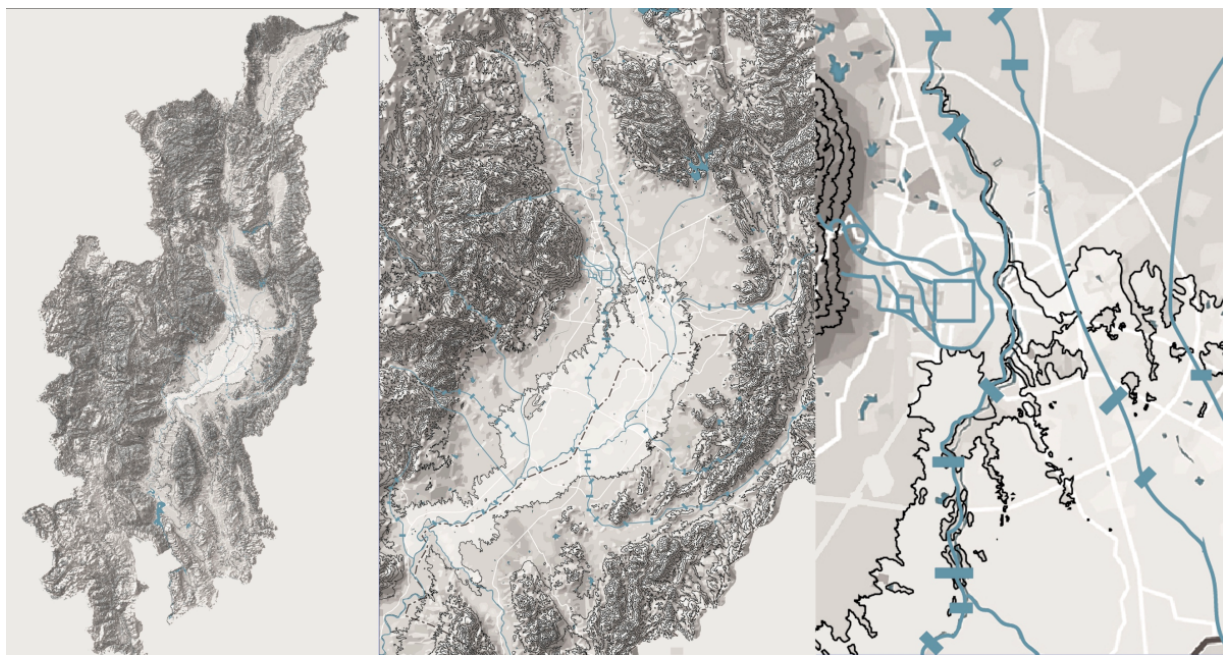
Figure 3. Three scales of the Chiang Mai-Lamphun Valley, a stomach-shaped valley with the royal moated city of Chiang Mai situated at a slightly higher table at the foothills of Mount Suteph, overlooking a lower flood plain southeast of the city. The water supply from the mountain to the old city is redrawn from the research of Surapon Dumrikul. Also shown are the major rivers and community managed weirs documented by P. T. Cohen and R. E.